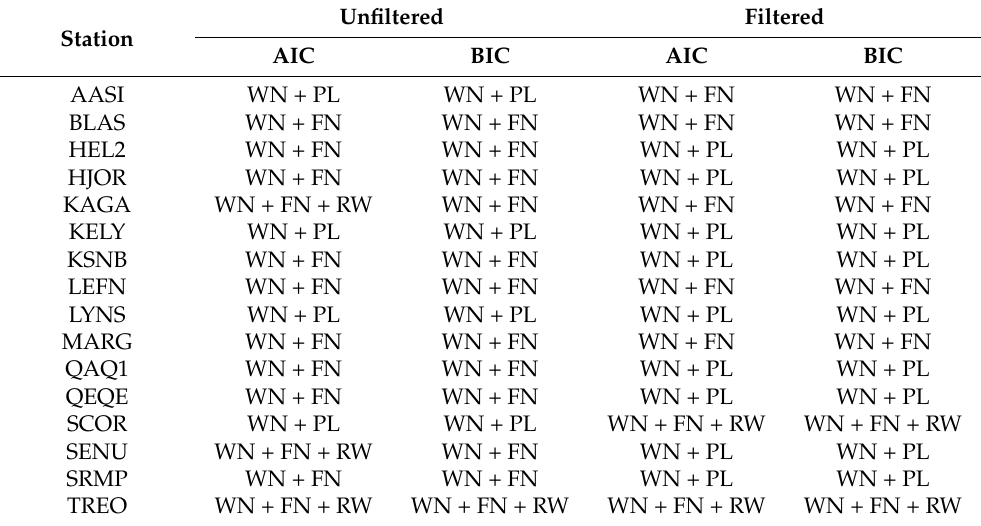
Table 2. The optimal noise model of GPS network determined by the AIC and BIC indicators.